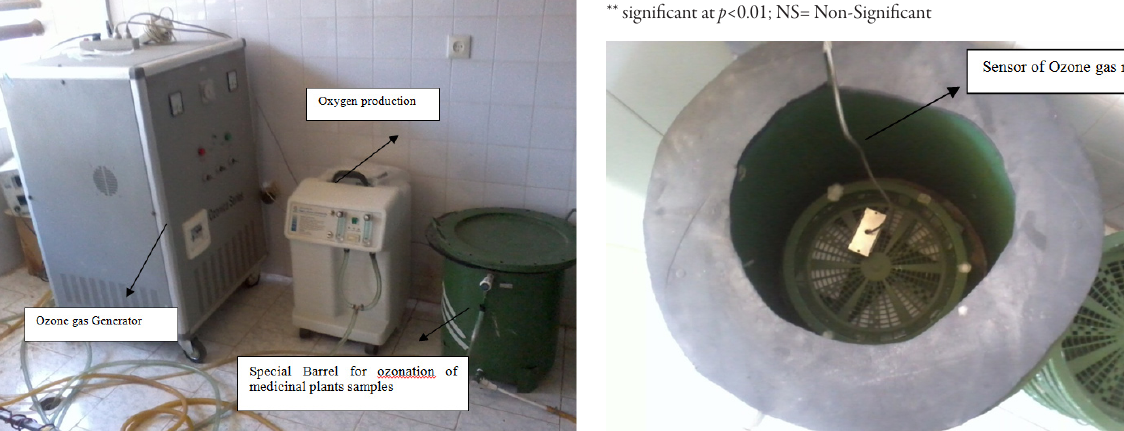
Fig. 1. Trial steps Fig. 2. The barrel of medicinal plants